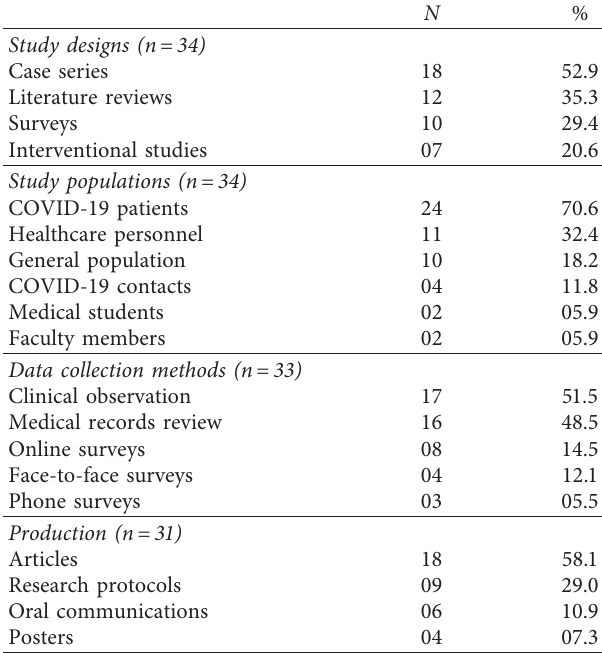
Table 2: COVID-19-related research activities and production among faculty members.